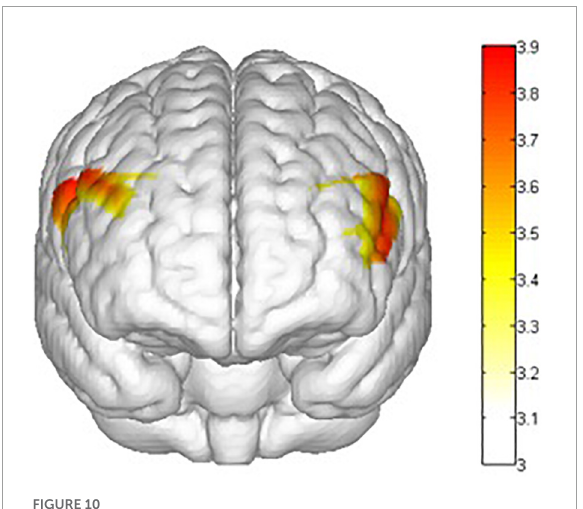
FIGURE10 Mapping of interaction effects F value. ch1, ch7, ch8, and ch22 had a lower activation degree ( β ) in the nogo task in the summer training conditions. All statistical parametric maps were created with a threshold of p <